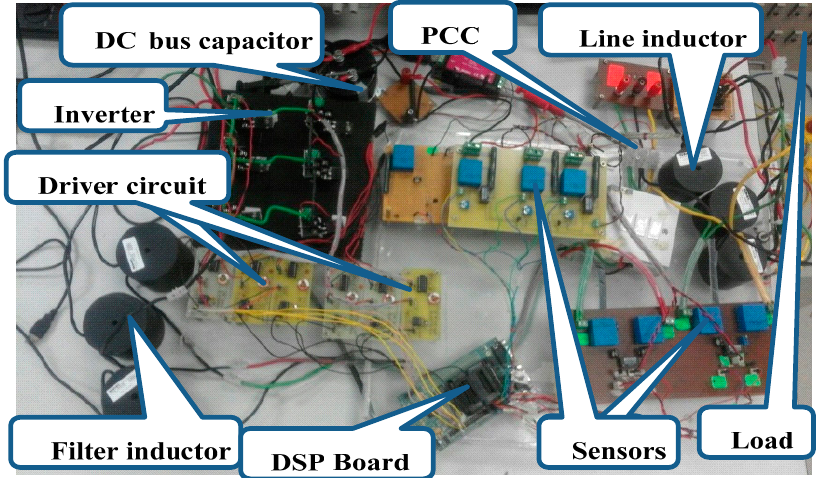
Figure 14. Picture of the hardware set up.